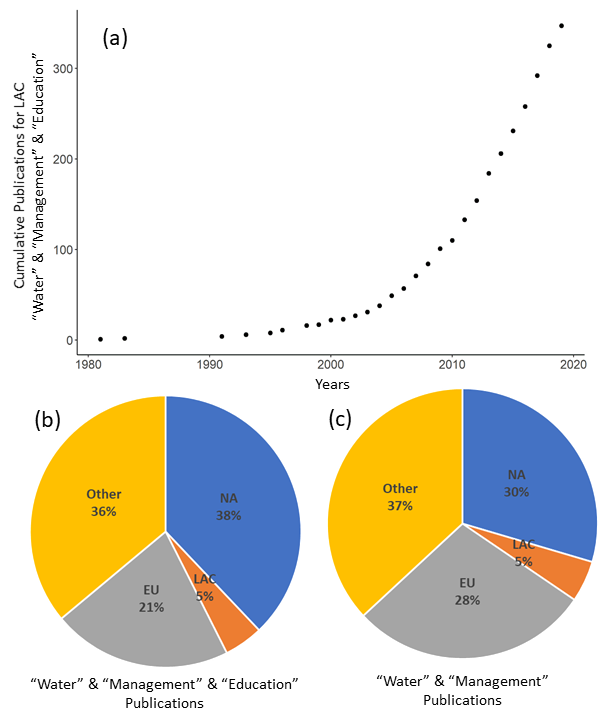
Figure 1. There has been an increasing output of publications for the Latin America and Caribbean (LAC) region on “water” and “management” and “education” over recent years ( a ). This increasing interest is despite a low proportion of the total global output as seen by the distribution of total publications with key words “water” and “management” and “education” ( b ) relative to “water” and “management” ( c ) in the LAC region, the European Union (EU) region, and the North America (NA) region from 1980 to